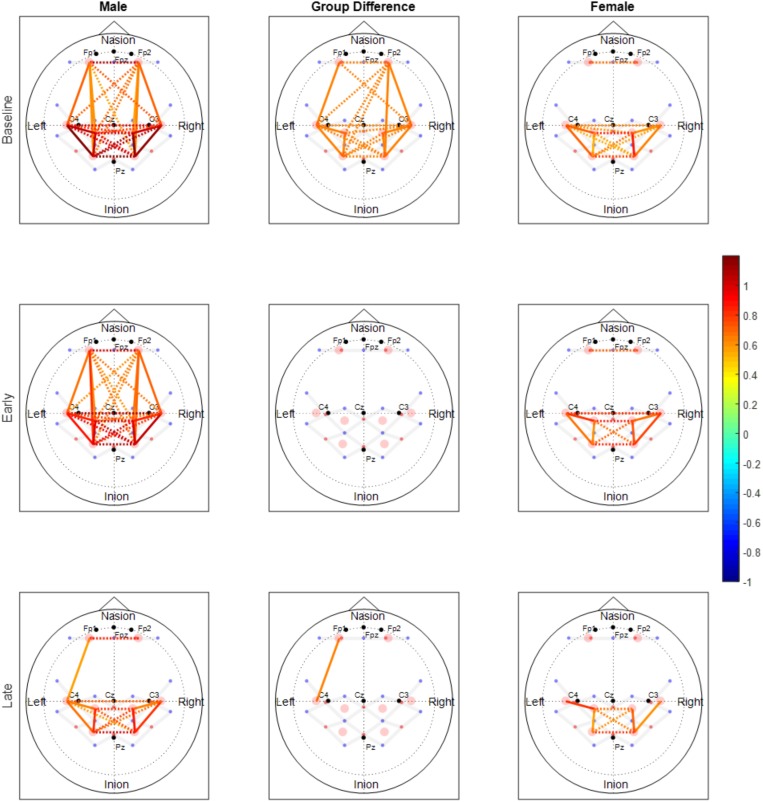
Functional connectivity maps of the male (left column) and female (right column) groups during the baseline and motor fatigue test. The connectivity maps are produced from the weighted matrix, and the color of each node depicts the strength of connectivity based on provided color scale. Nodes with solid lines indicate intra-hemispheric connectivity, and nodes with dotted lines indicate inter-hemispheric connectivity. Middle column shows the nodes where connectivity was significantly different between the sexes. The connectivity difference maps are produced from the binary matrix, and positive score based on the provided color scale indicates connectivity of the nodes were significantly stronger for males than for females.